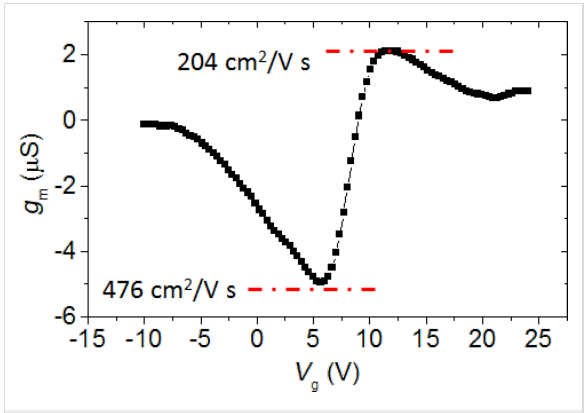
Figure 6: Transfer conductance, g m , of the Gr-FET, calculated from the I d vs V g transfer